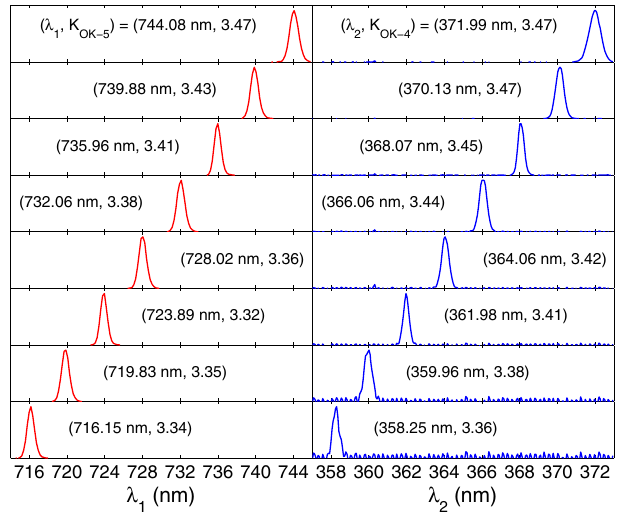
FIG. 4. Wavelength tuning with the UV wavelength set to the second harmonic of the IR wavelength using the four-undulator configuration and loss curves L2. λ 1 is tuned from 716.15 nm to 744.08 nm and λ 2 is varied from 358.25 nm to 371.99 nm simultaneously. During the measurement, the beam current was maintained between 12.35 mA and 12.94